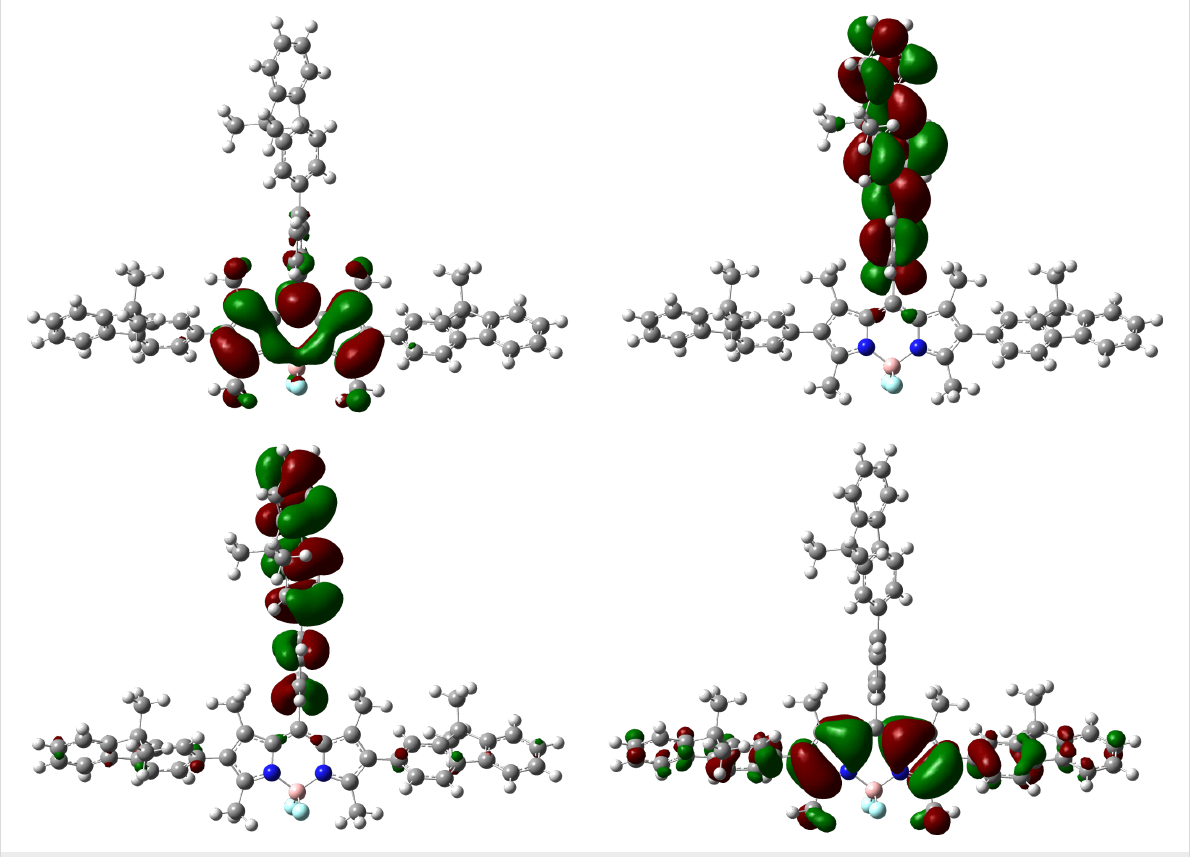
Figure 6: HOMO − 1 (bottom, left), HOMO (bottom, right), LUMO (top, left) and LUMO+1 (top, right) of T-B1 .